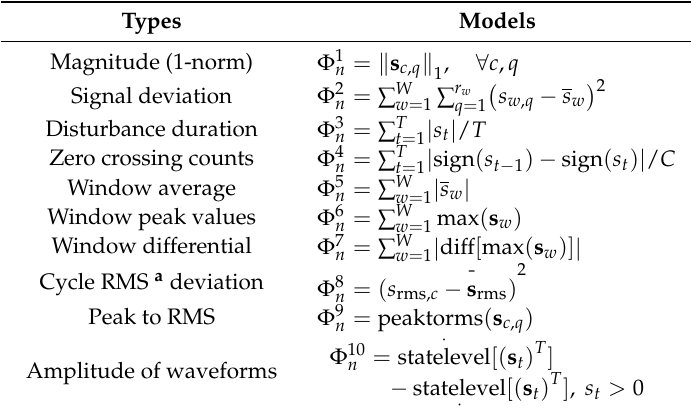
Table 1. Feature list of categorized